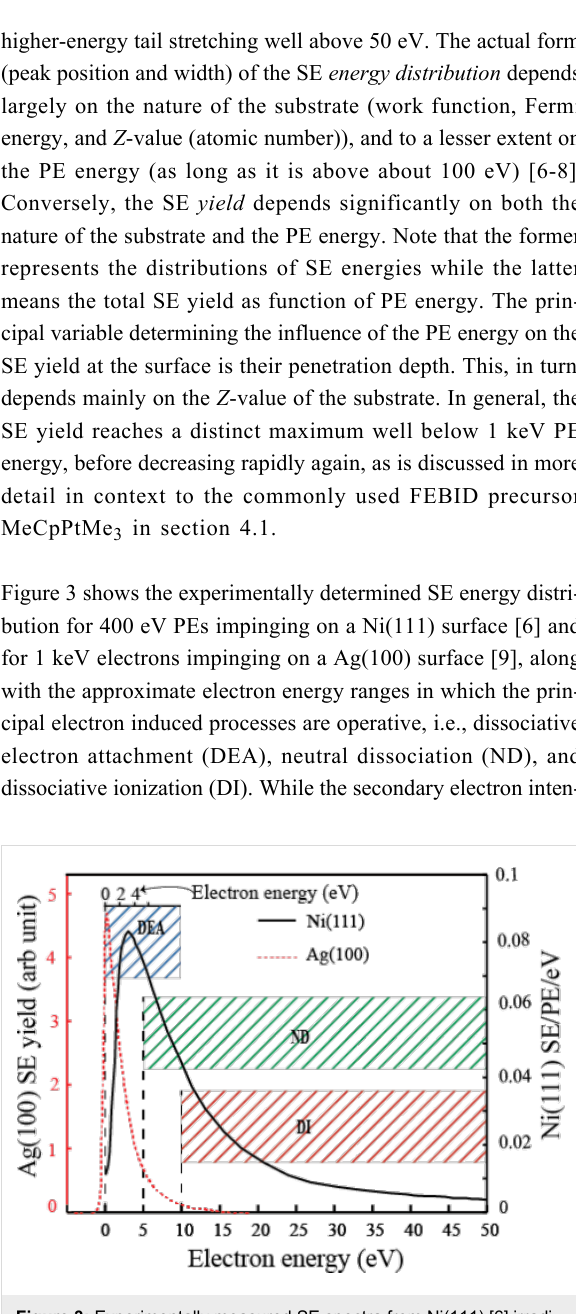
Figure 3: Experimentally measured SE spectra from Ni(111) [6] irradi- ated by PEs with 400 eV impact energy (black solid line) and from Ag(100) [9] subjected to PEs with 1 keV impact energy (red dotted line). The left-hand y -axis shows the relative SE intensity from Ag(100), while the right-hand y -axis shows the absolute SE intensity from Ni(111) in SEs per PE per eV (SE/PE/eV). The vertical bars show the approximate electron energy ranges in which the principal electron induced processes are operative, i.e., dissociative electron attachment (DEA), neutral dissociation (ND), and dissociative ionization (DI). The relative extent of these different electron-induced fragmentation processes will depend not only on their relative cross sections, but also on the actual SE energy distribution. From the data shown here, for example, high cross section DEA processes at low energies would likely be dominating for Ag(100) while the integral efficiency of DI and ND processes at higher energies would be more important for Ni(111) (see also